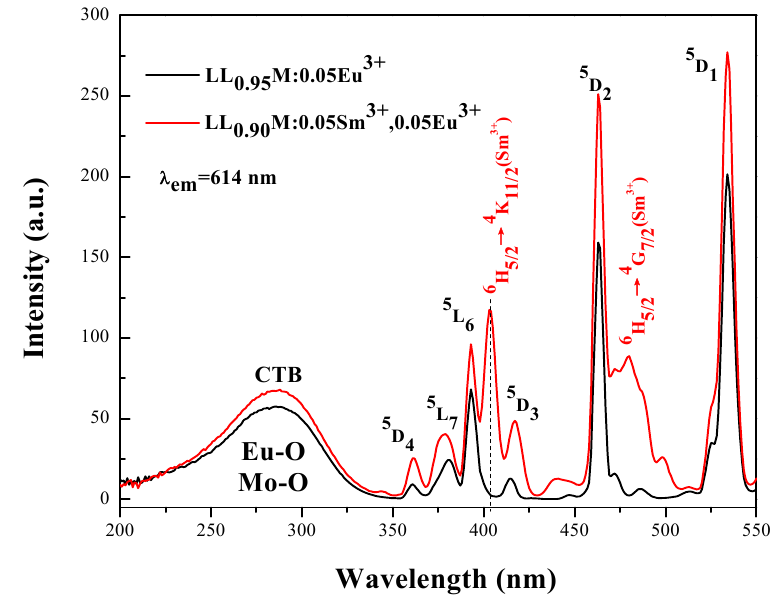
Figure 4. The PLE (photoluminescence excitation) spectrum of LL 0.95 M:0.05Eu 3+ and LL 0.90 M:0.05Sm 3+ ,0.05Eu 3+ phosphors by monitoring the 5 D 0 → 7 F 2 emission of Eu 3+ at 614 nm.